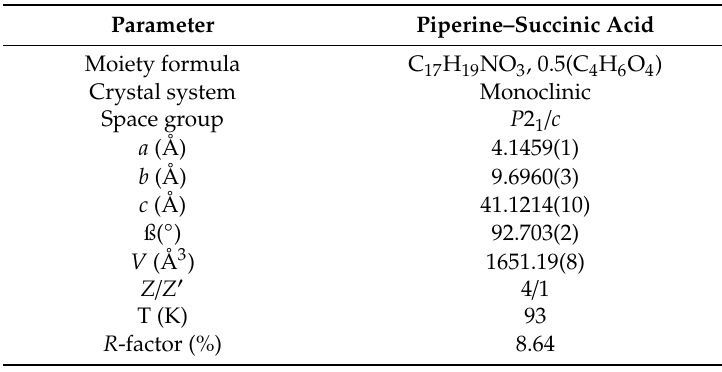
Table 1. Crystal data for the piperine–succinic acid cocrystal.